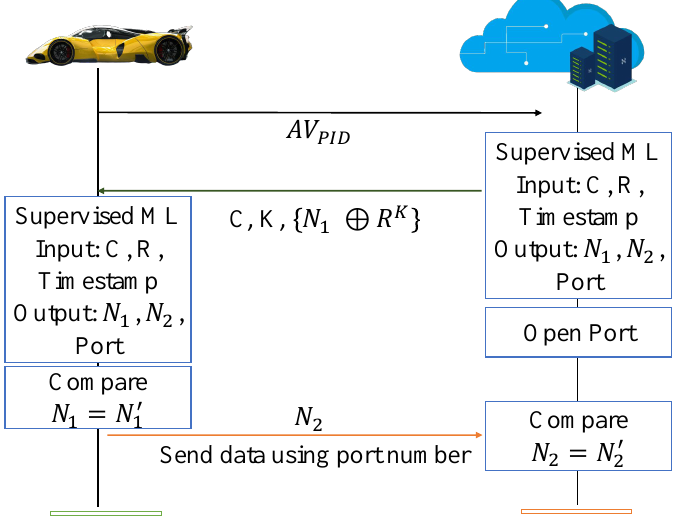
Figure 7. PUF and SML based authentication